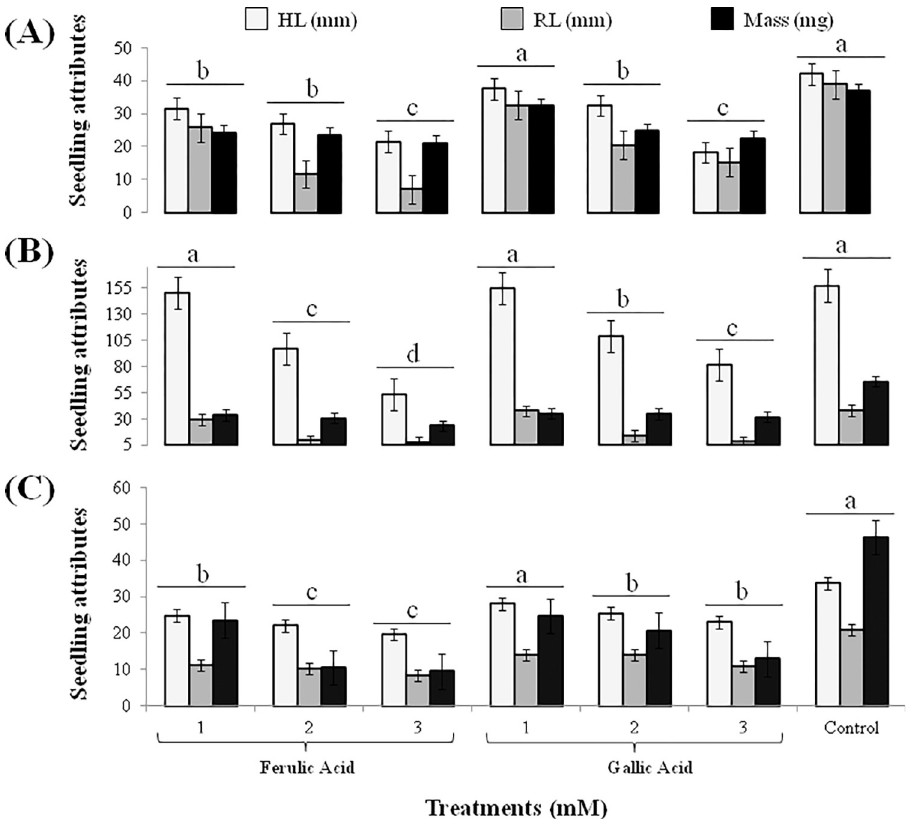
Fig 2. Seedling attributes i.e., hypocotyl length (HL), radicle length (RL) and mass of weeds after treatment with 1, 2 and 3 mM ferulic acid (FA) and gallic acid (GA). (A) effect on Sinapis arvensis ; (B) effect on Lolium multiflorum ; (C) effect on Parthenium hysterophorus . Values are presented as mean ± SE (n = 10). Bar values with different letters differ significantly from each other at P < 0.05.